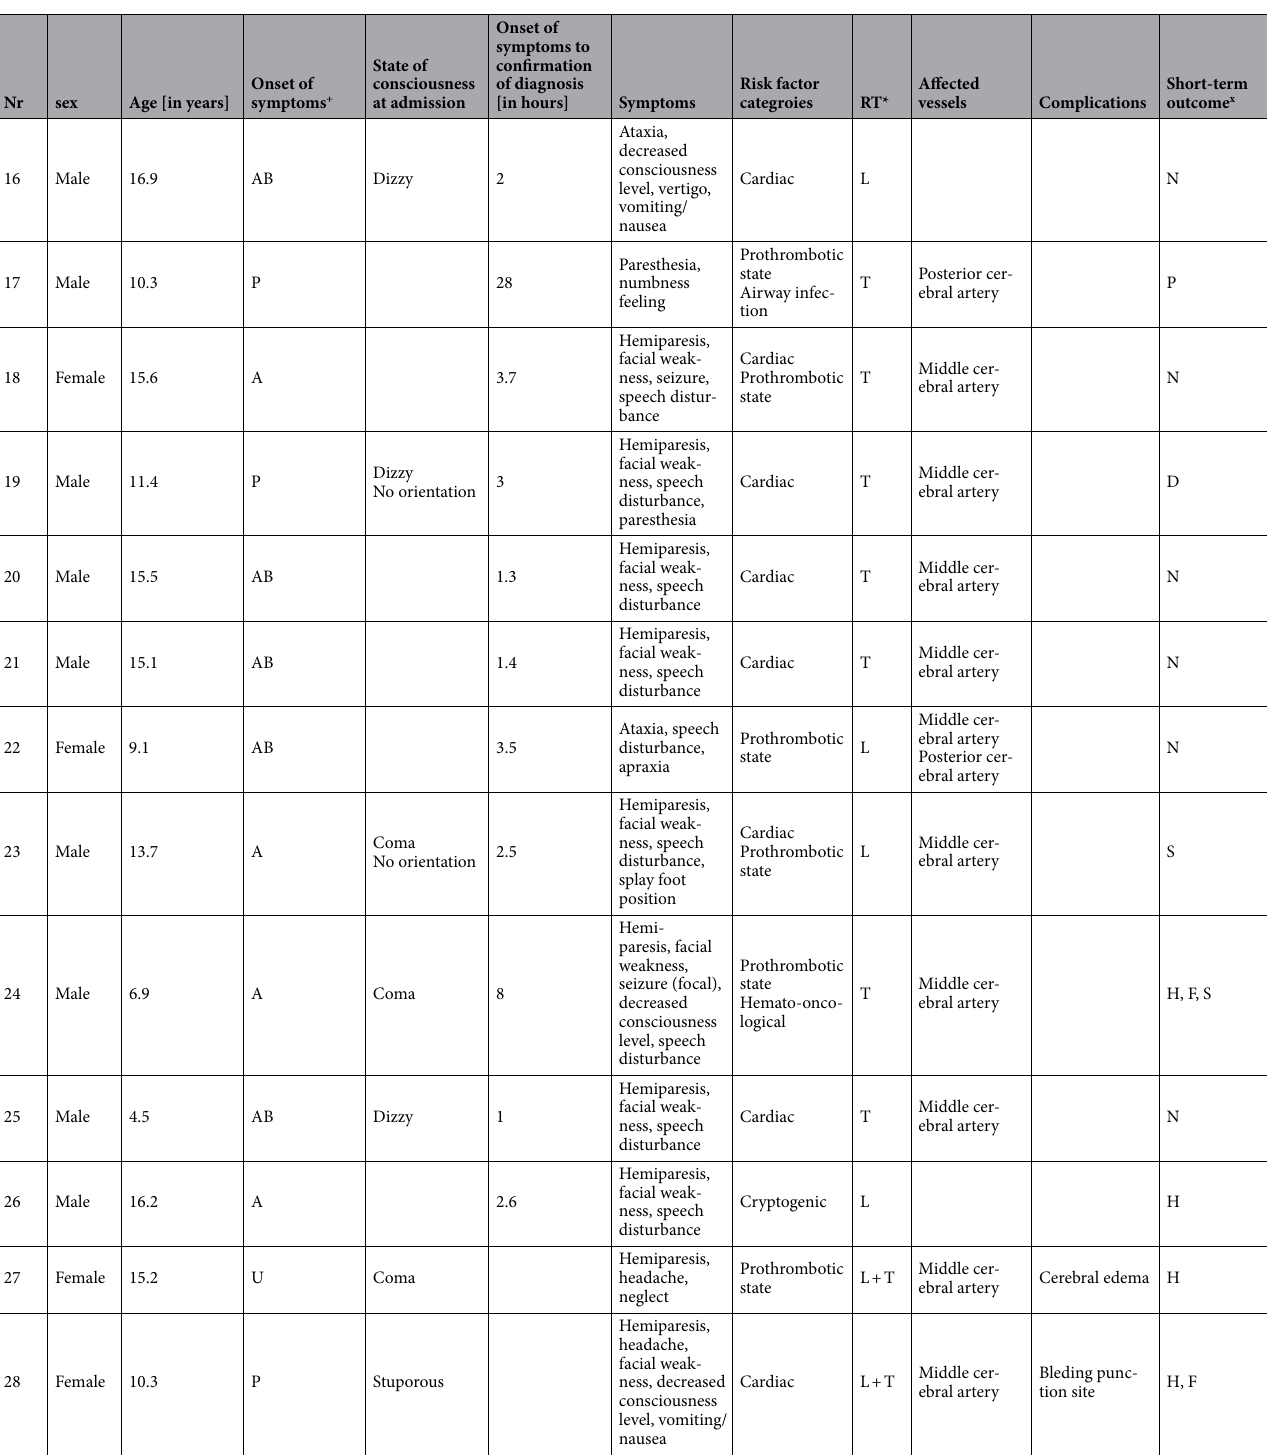
Table 2. Individual patient characteristics. Characteristics of each patient in the recanalisation group (n = 28). + A = acute (within minutes), AB = abrupt (within seconds), P = Progressive (within hours) U =